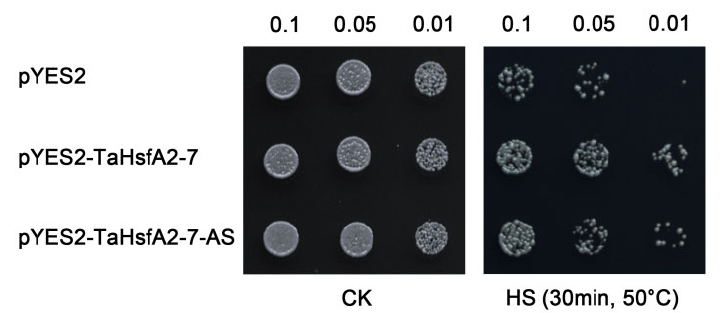
Figure 4. Thermotolerance assay of TaHsfA2-7-AS in yeast. Growth status of transgenic yeast are assessed in response to heat stress by spotting on SD/-Ura media. The control without HS was established in parallel. 0.1, 0.05, 0.01 represent the serial gradient dilutions.